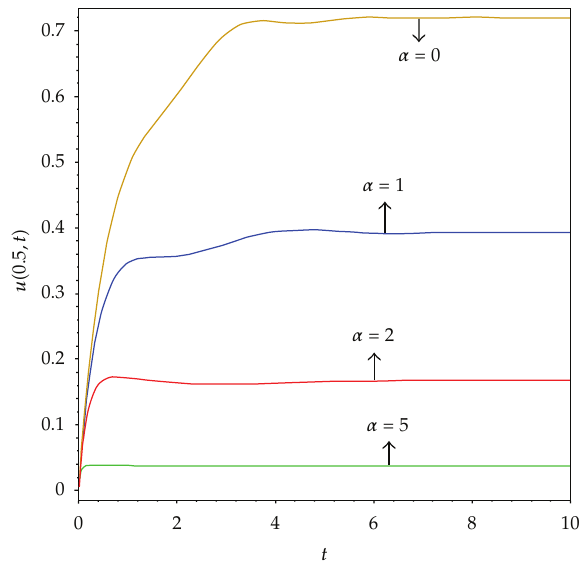
Figure 3: The e ff ect of the porous medium parameter α 2 on the centerline velocity profile for S 1 (cid:8) 2, S 2 (cid:8) 1, μ 1 (cid:8) 10, and h (cid:8)